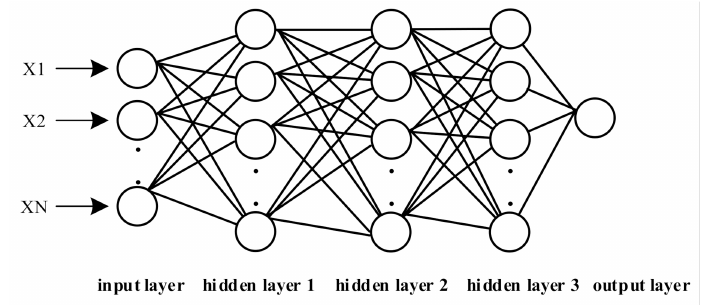
Figure 1. The ANN used in the